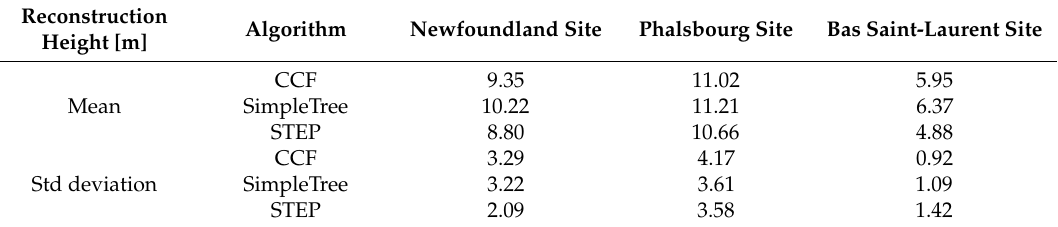
Table 2. Reconstruction height with the three